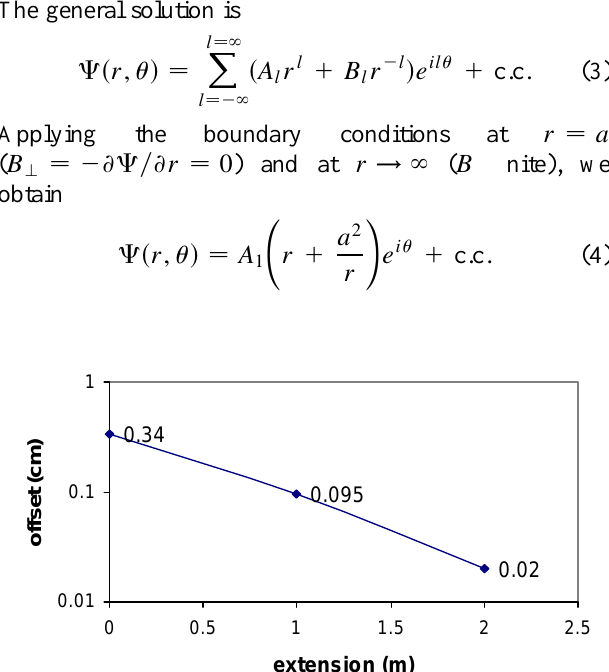
The general solution is